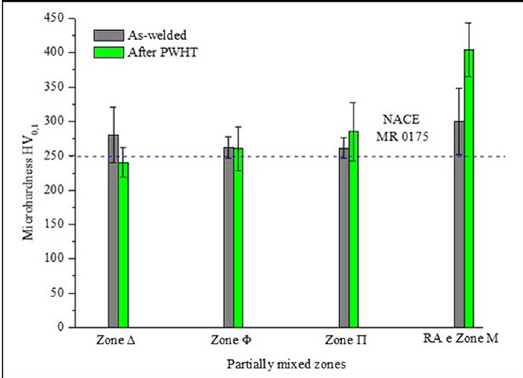
Figure 12. Mean microhardness values and standard deviation for PMZs.